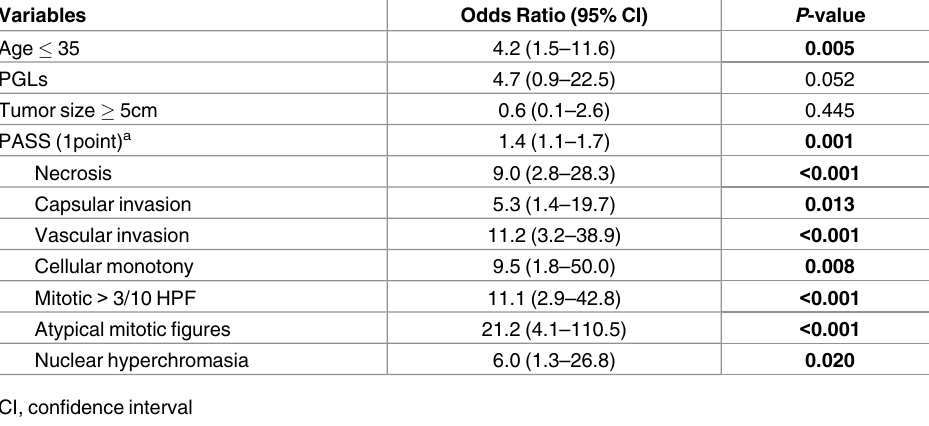
Table 3. Logistic regression models predicting malignancy in patients with initially “benign” PPGLs.